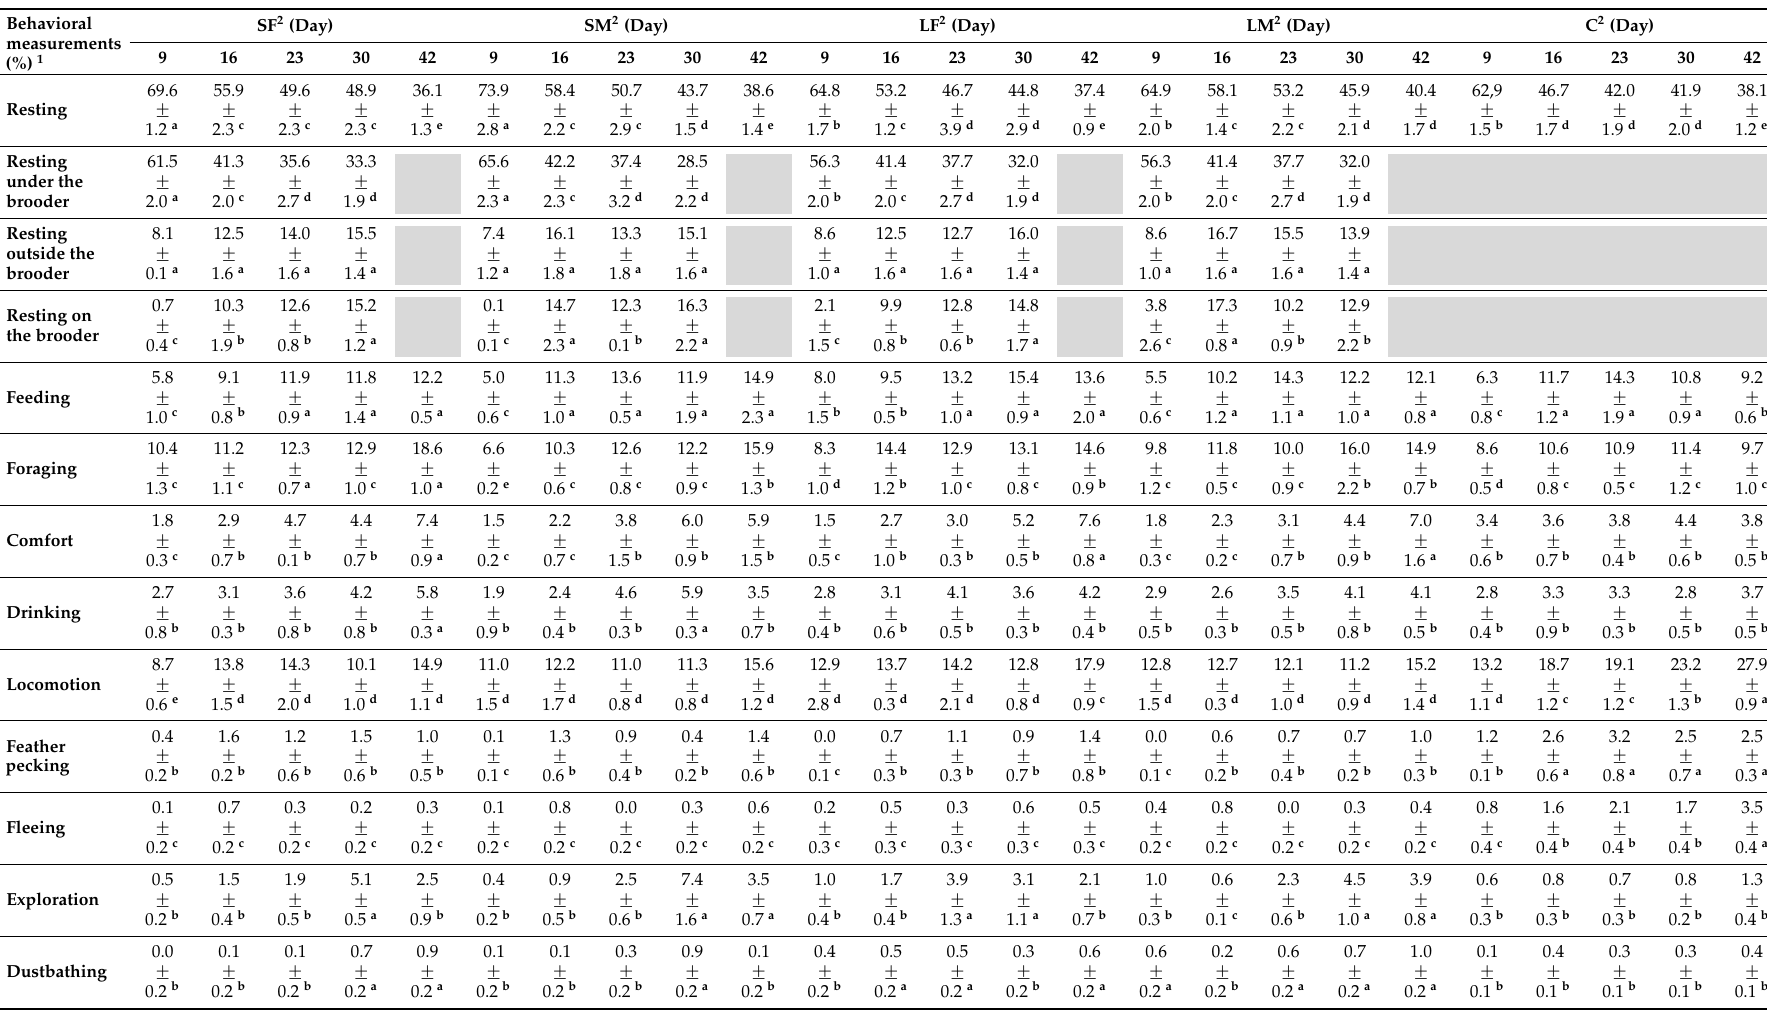
Table 2. Proportion of layers (%) performing various behavioral categories when 9, 16, 23, 30, and 42 days old. Gray shaded areas indicate no available brooders. Behavioral measurements (%) 1 Resting Resting under the Resting outside the brooder Resting on the